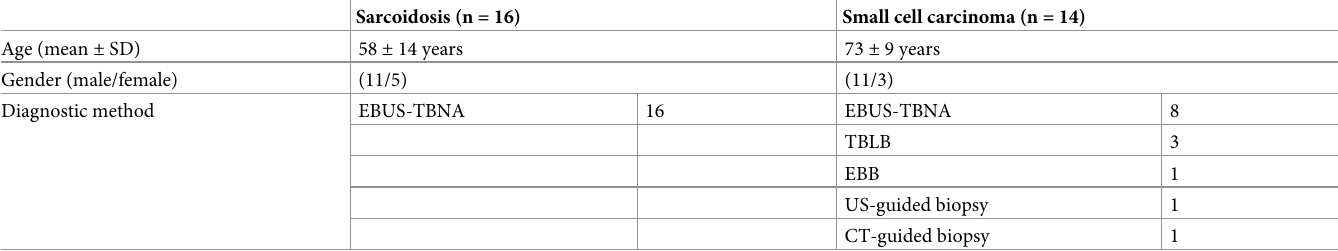
Table 1. Clinical characteristics of study